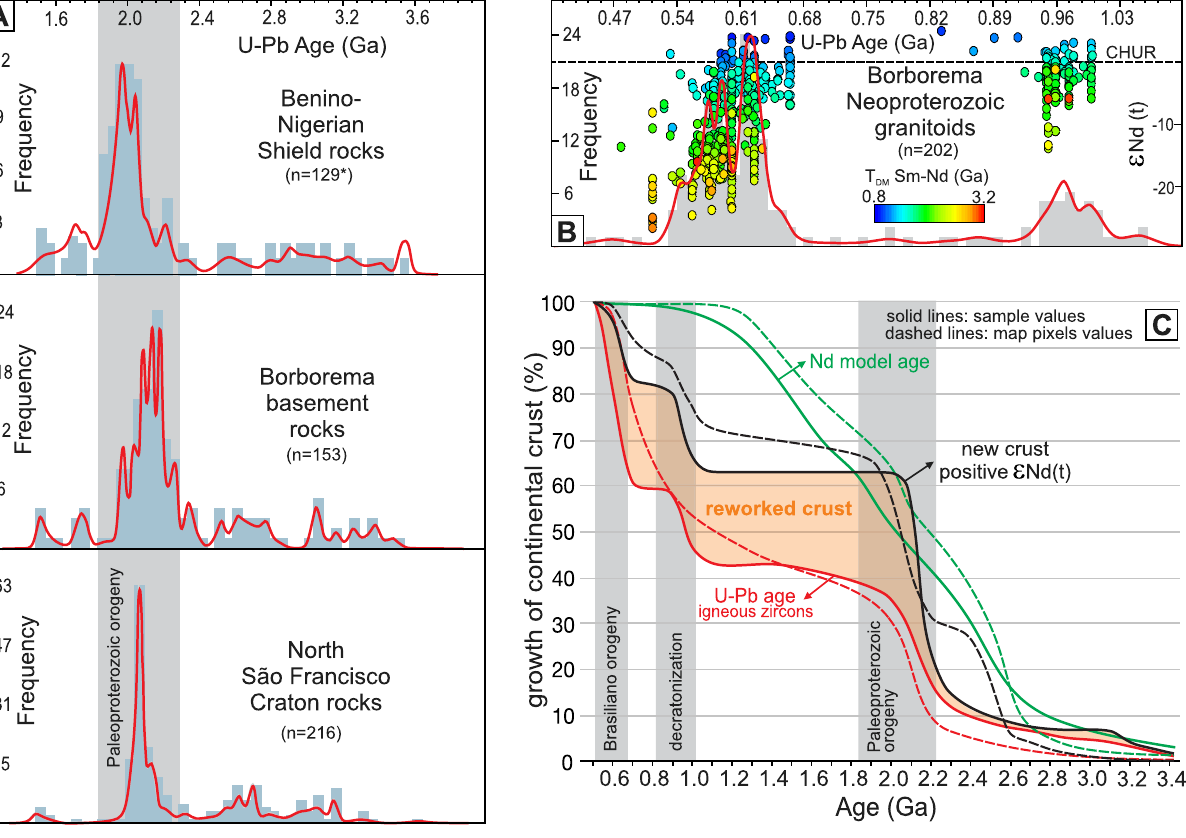
Figure 2. Zircon U–Pb, Nd whole-rock data and crustal growth. ( A ) Similarity of zircon U–Pb crystallization age distribution for the North São Francisco Craton, Benino-Nigerian Shield and Borborema Province (see “Methods” section for explanations on data compilation). ( B ) Zircon U–Pb crystallization ages for the Neoproterozoic magmatism in the Borborema Province and their ε Nd(t) values and T DM (given by the colour of the circles). Data show increased involvement of old crust during the Brasiliano Orogen, as oceanic basins closed, and collision progressed (see “Methods” section for data compilation). ( C ) Continental growth for the Borborema Province using data from samples of igneous and metaigneous rocks (solid lines) and exposed area coverd by these rocks based on pixel values from the maps in Fig. 1D, E (dashed lines). Colour of the lines represent cumulative U–Pb ages (red), ε Nd(t) < 0 (black) and Nd model ages (green), binned for each 100 Myr interval from 3.4 to 0.5 Ga. Growth is estimated from the cumulative proportion of juvenile crustal addition using the ε Nd(t) cut-off value of zero for the igneous and metaigneous rock samples and gridded pixels for the crystalline igneous and metaigneous areas from the maps in Fig. 1D, E (see “Methods” and 1.0 Ga with source areas dominated by rocks ranging from 0.9 to 1.0 Ga. A subgroup of samples in G2 also shows source areas dominated by Paleoproterozoic and Archean rocks such as those in G1. The last group (G3) comprises samples with youngest zircon ages between 0.5 and 0.7 Ga, representing the youngest sedimentary record in the province, associated with syn-orogenic sedimentation. The source areas of G3 vary from rocks with ages in the range of 0.65 to 0.52 Ga, such as the foreland strata of the Sergipano fold-and-thrust belt 16 , to rocks with source components from 1.0 to 0.65 Ga and even older (Fig. 3A and B).